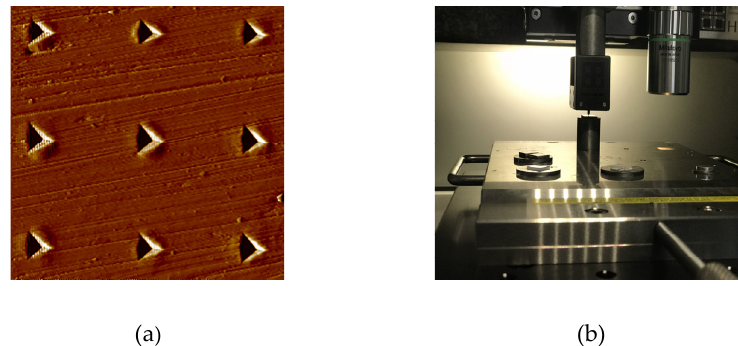
Figure 3. Nanoindentation test: ( a ) Protrusion and depression of the indentation. ( b ) Nanoindentation test processes.